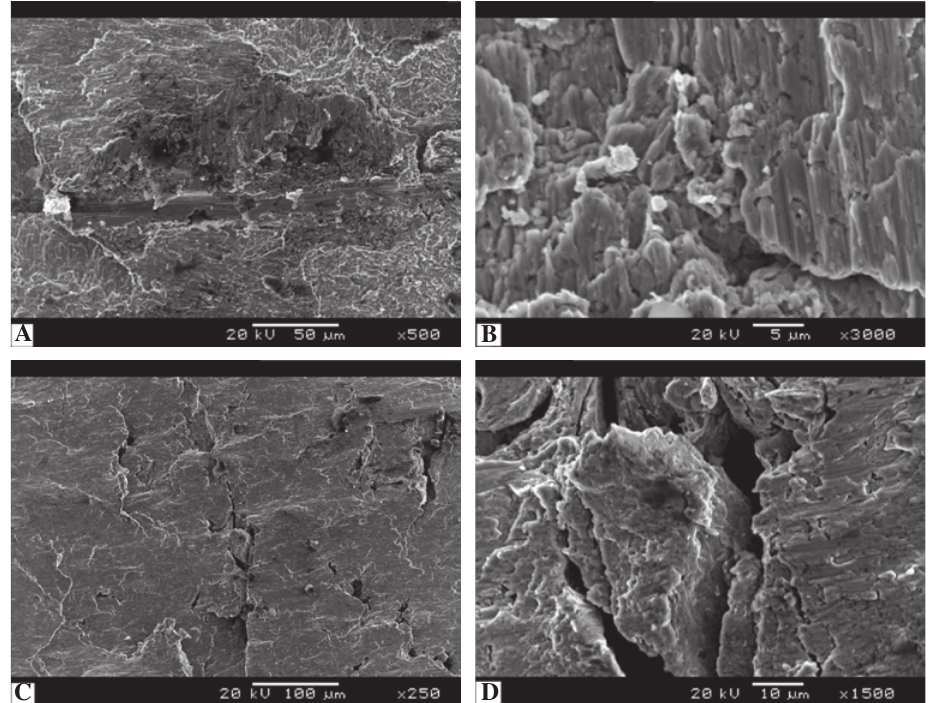
alloy compacts depending on the milling time: (A), (B) 5 h, (C), (D) 25 h. Figure 8 Fracture surface of Cu-7vol.%ZrB 2 homogenous alloys have better mechanical